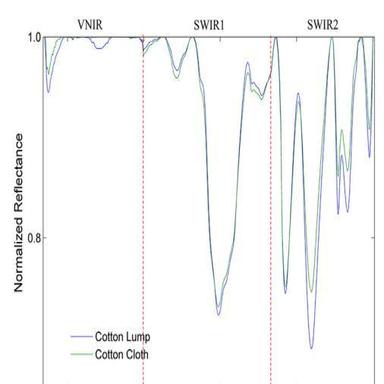
Spectral comparison between textile samples with different physical properties. (the 1st column: reflectance spectra; the 2nd column: CR spectra).